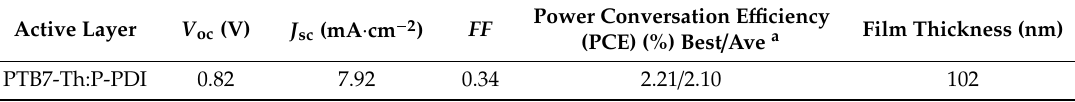
Figure 2. J-V ( a ) and external quantum efficiency (EQE) ( b ) curves of PTB7-Th:P-PDI based optimized devices. Table 1. Summary of the photovoltaic properties of PTB7-Th:P-PDI based devices.